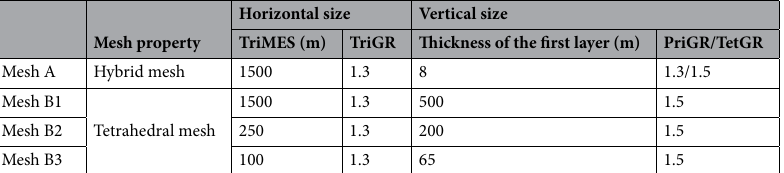
Horizontal size Vertical size Mesh property TriMES (m) TriGR Thickness of the first layer (m)